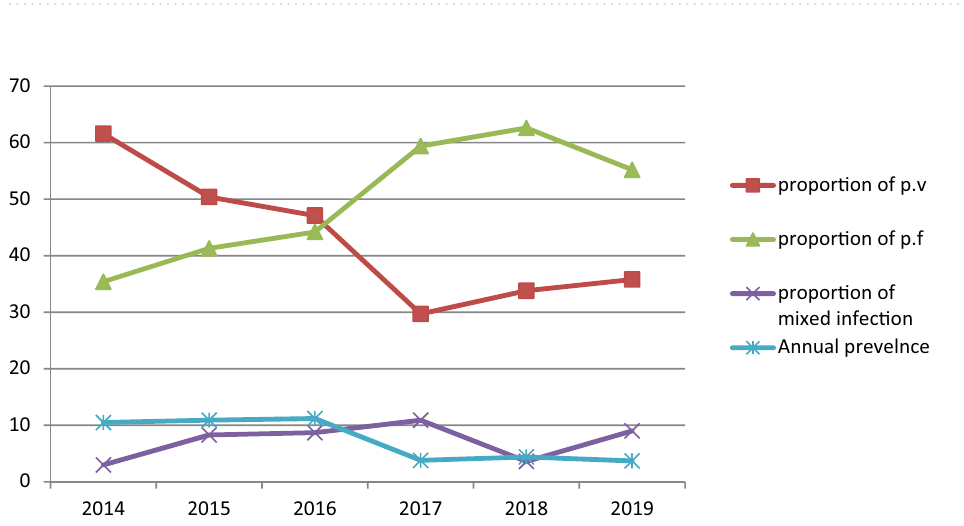
Table 2. Annual trend of malaria prevalence and proportion of plasmodium species in each year among patients requested for malaria examination at University of Gondar Specialized Referral Hospital from 2014 to 2019. CI confidence interval, P.f plasmodium falciparum, P.v plasmodium vivax.